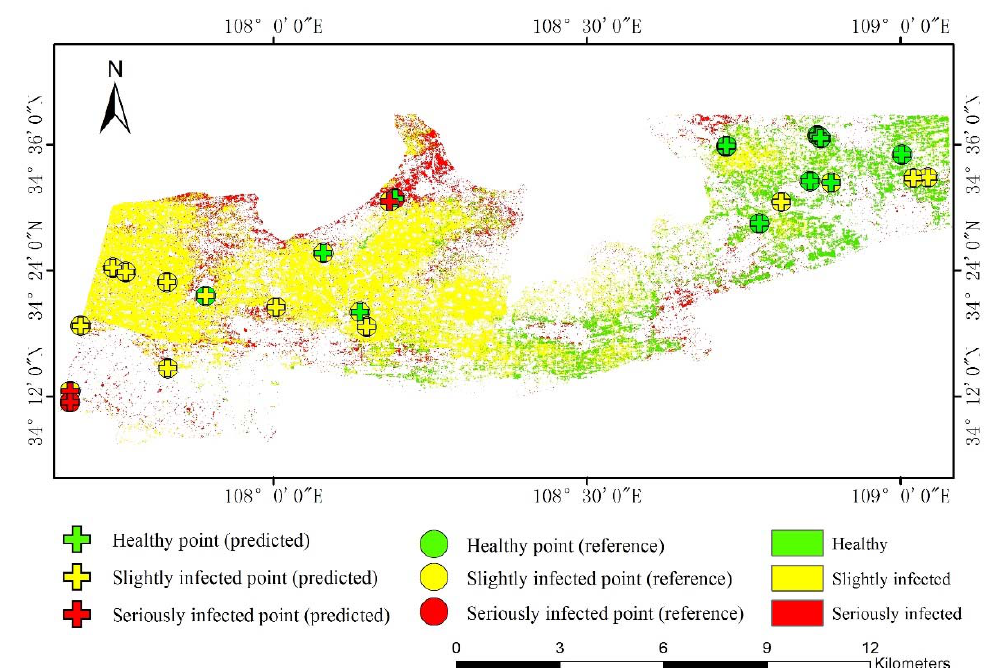
Figure 5. The infection map of powdery mildew in Western Guanzhong Plain produced by OpTrAdaBoost. Green represents estimated healthy wheat, yellow represents estimated slightly infected wheat, and red represents estimated seriously infected wheat. Green circles are healthy samples, yellow circles are slightly infected samples, and red circles are seriously infected samples. Green crosses are estimated healthy wheat at the location of samples, yellow crosses are estimated slighted infected wheat at the location of samples, and red crosses are estimated seriously infected wheat at the location of samples.